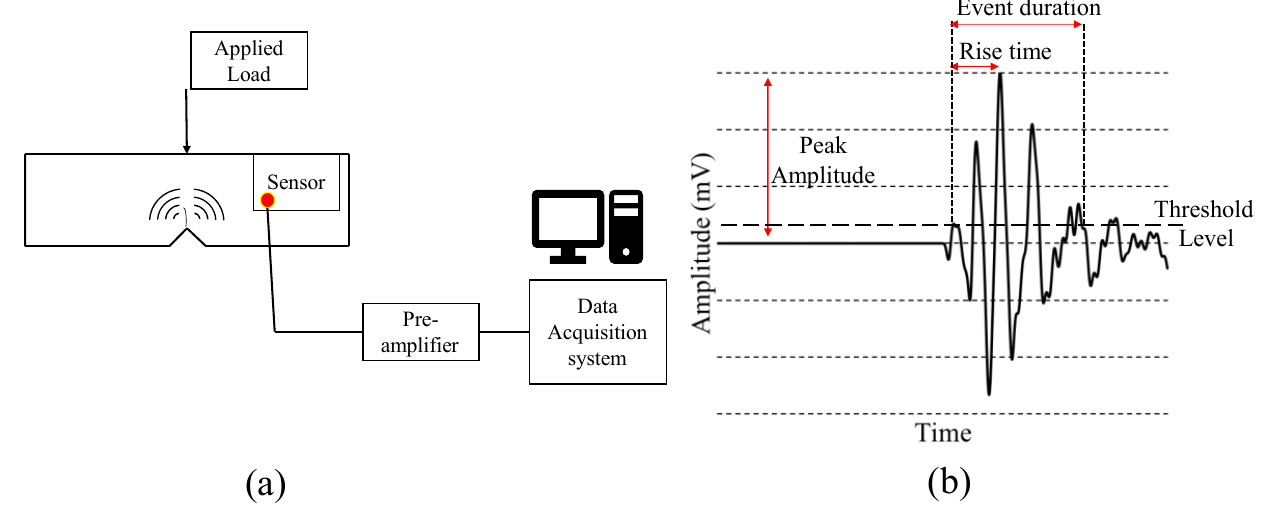
Figure 1. AE testing of structure ( a ) AE testing setup ( b ) Typical AE signal.